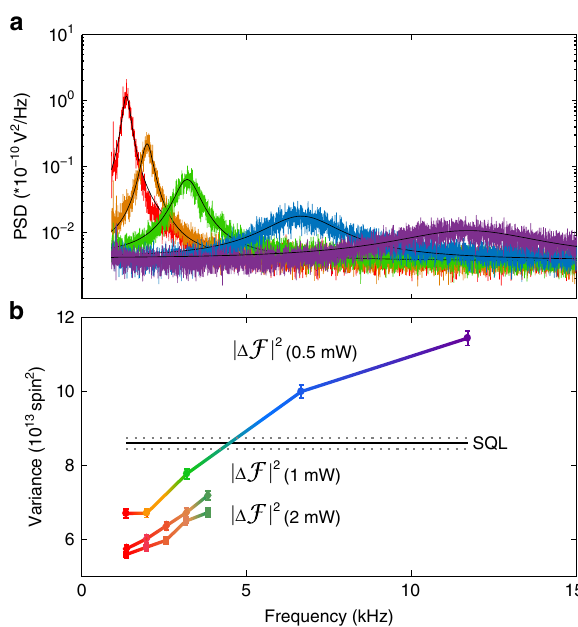
Fig. 2 Quantum non-demolition detection of collective spin in the strongly-interacting regime. a Spin noise spectra with atomic spin signal driven by thermal fl uctuations and precessing at the Larmor frequency ( ν L = ω π ) rising above shot noise of the Faraday rotation probe. Different L /2 spectra correspond to different bias fi eld strengths. Black lines are single Lorentz fi ts for the spectra. Comparing the red and purple curves, we see a roughly 100-fold improvement in signal to noise ratio (SNR) due to suppression of SE relaxation and consequent line narrowing, which indicated a stronger quantum non-demolition (QND) interaction. b Spin variance versus Larmor frequency. Black solid-line shows the standard quantum limit of total spin (SQL = N A 13/8). Dashed horizontal lines indicate standard quantum limit (SQL) ±1 σ statistical uncertainty. Round symbols show Δ F j j 2 measured with 0.5mW probe light, corresponding to the spectra in ( a ). Diamonds and squares show Δ F j j 2 measured with 1mW and 2 mW probe light respectively. All error bars show ±1 σ uncertainty due to uncertainty in atomic number, including uncertainties in atomic density and effective volume (see “ Methods ” , “ Density calibration ” section). We test for long-range singlet-type entanglement by applying a weak gradient B 0 (cid:5) d B j j = dz during the cw probing process. A